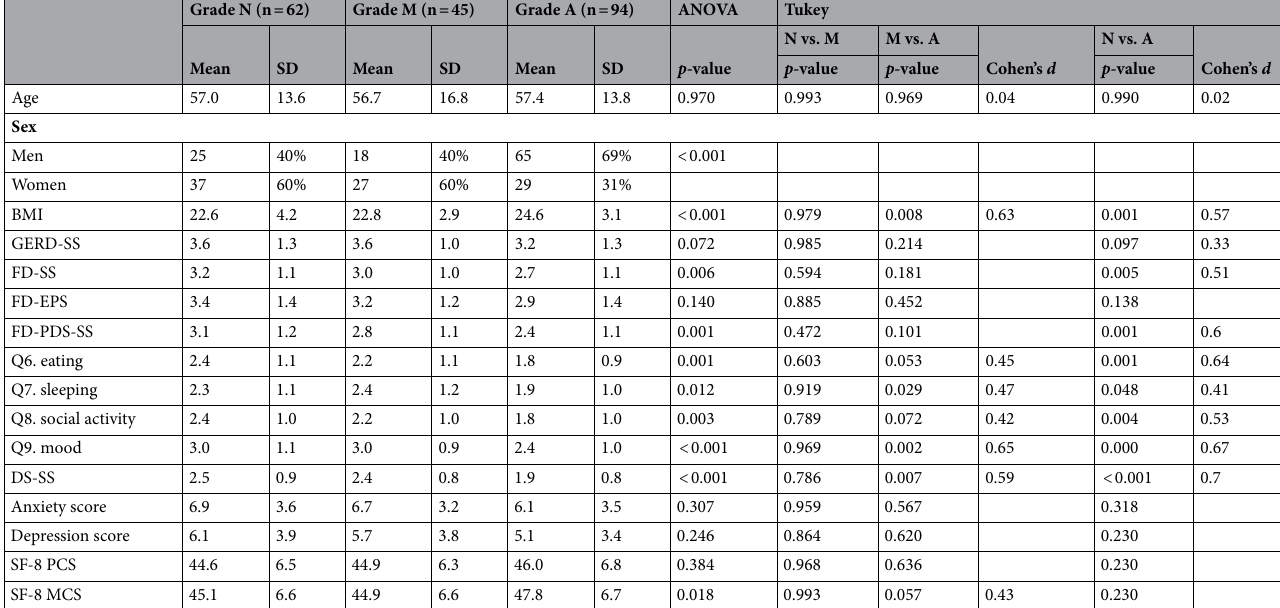
Table 1. Comparison of patients’ backgrounds and clinical characteristics among the three groups. ANOVA, analysis of variance; SD, standard deviation; BMI, body mass index; GERD-SS, gastroesophageal reflux disease symptom subscale; FD-SS, functional dyspepsia symptom subscale; FD-EPS-SS, functional dyspepsia/ epigastric pain symptom subscale; FD-PDS-SS, functional dyspepsia/postprandial distress symptom subscale; DS-SS, dissatisfaction with daily life subscale; SF-8, Short Form-8; PCS, physical component summary; MCS, mental component